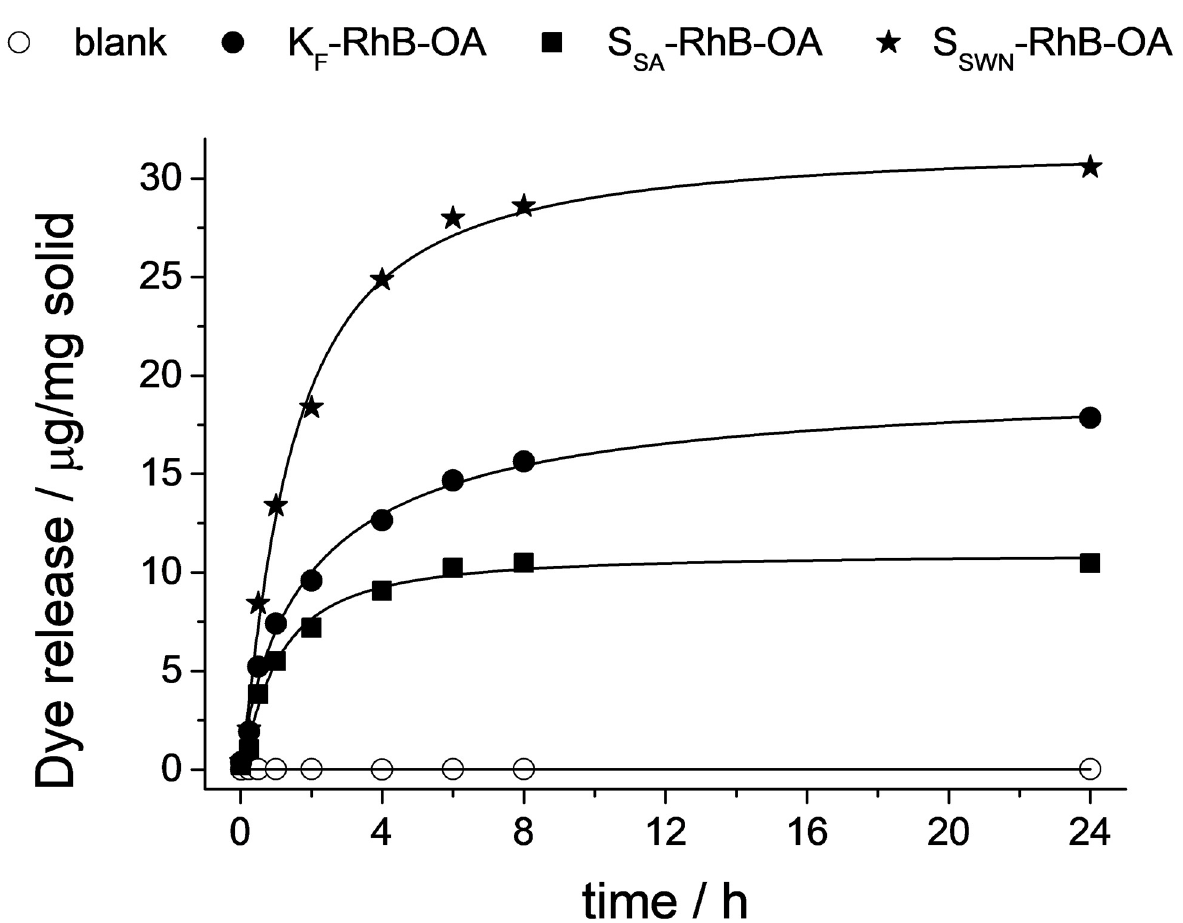
) and in the (cid:35)